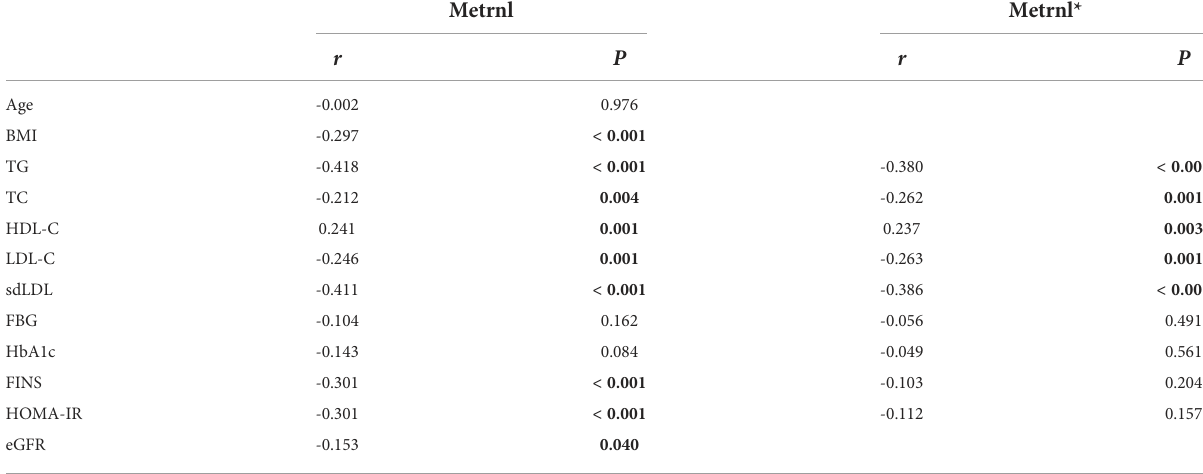
TABLE 3 Correlation analysis between serum Mternl levels and clinical variables.